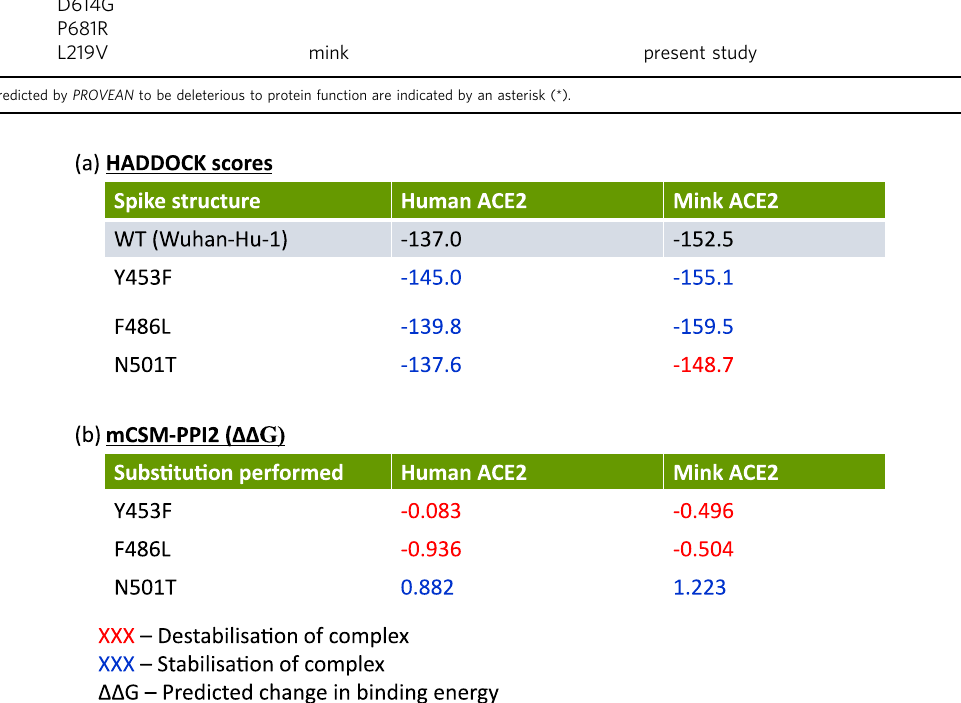
Fig. 6 Predicted effects of candidate mutations. a HADDOCK scores for the Spike:ACE2 complexes. More negative values relative to the WT-Spike:ACE2 complexes (highlighted in grey) indicate stronger binding energy of the complex. b mCSM-PPI2 predicted changes in binding energy ( ΔΔ G). Negative ΔΔ G values are associated with destabilisation of the complex following mutation of the residue and positive values with stabilisation of the complex. Values in blue and red indicate predicted increases or decreases in complex stability